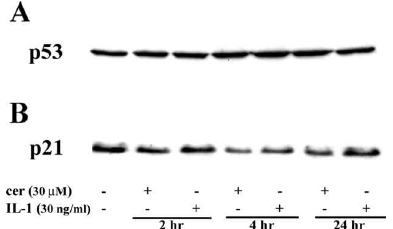
FIG. 3. A representative Western blot ( n = 5) showing the effect of IL-1 (30ng/ml) and ceramide (30 m M) on the levels of protein regulators of apoptosis. (A) Both IL-1 and ceramide caused a sharp decrease in bax protein levels 1h after treatment, and bax was abolished by 24h. (B) Both IL-1 and ceramide caused an increase in bcl-2 levels 4h after treatment.